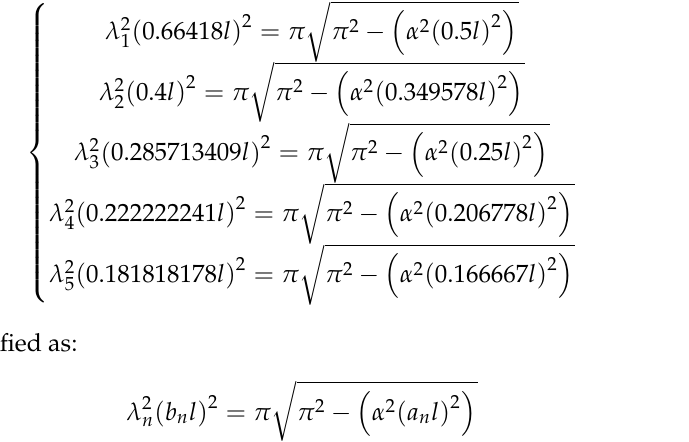
Table 1. Calculation of the length coefficients.